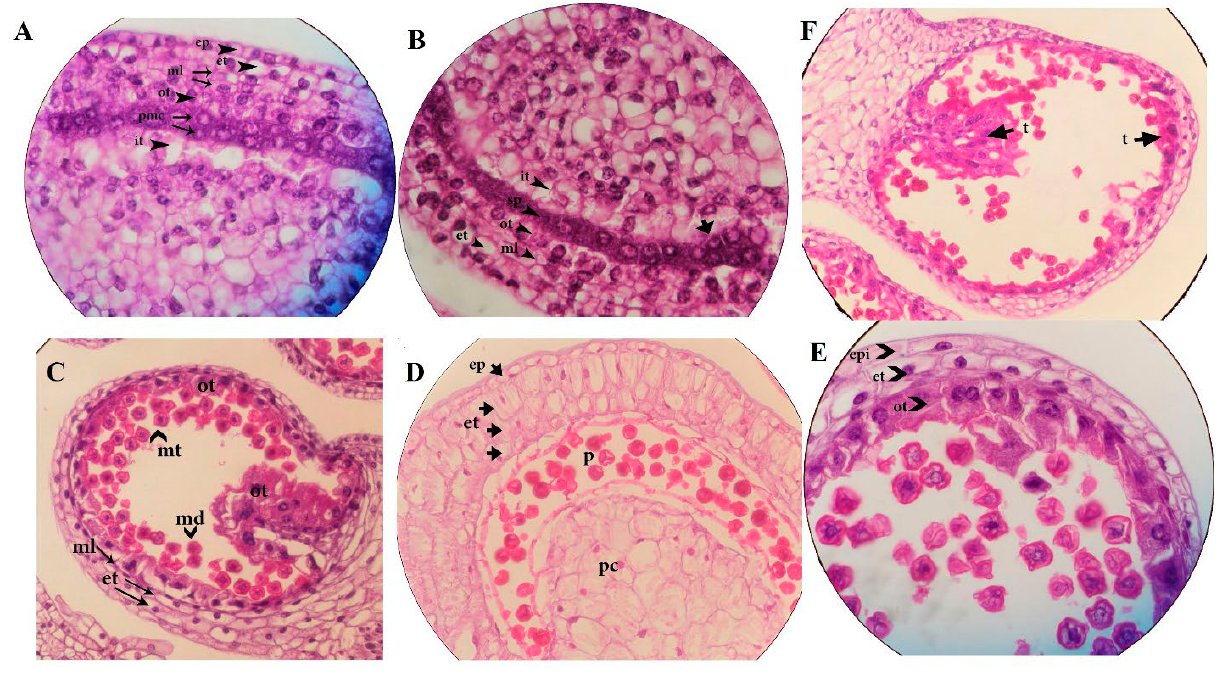
Figure 4. (A) The young anther wall layers and bilayer sporogenous tissue; (B) Anther sporogenous tissue is forming; (C) Degenerating mid- dle layers and dividing endothecium cells at a single locule of anther. (D) Transverse section of a single locule of mature anther before dehis- cence showing degenerating intersporangial septum and anther wall with only epidermis and endothecium; (E) Two-nucleated glandular tapetal cells on the outer side of anther wall; (F) Transverse section of microsporangium showing outer and inner binucleate tapetal cells, dis- integrating callose in microspores tetrads and anther wall layers (et – endothecium; ep – epidermis; it – inner tapetum; ml – middle layer; mt – microspore tetrads; md – microspore diad; ot – outer tapetum; pmc – pollen mother cell; p – pollen grain; pc – placentoids; t –